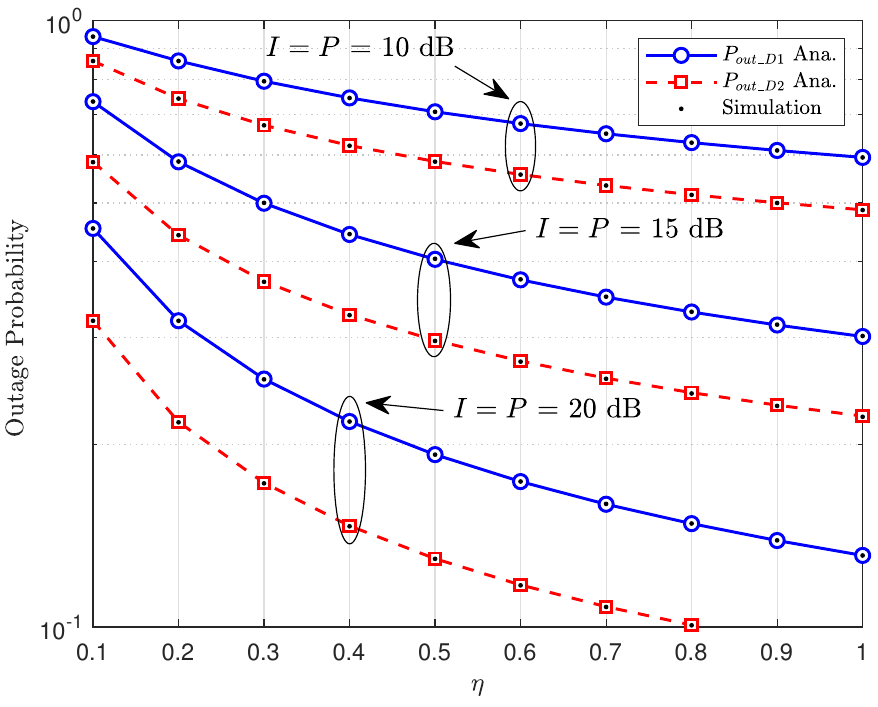
Figure 5. Impact of percentage of harvested power at RSU on outage performance with different cases of I , P